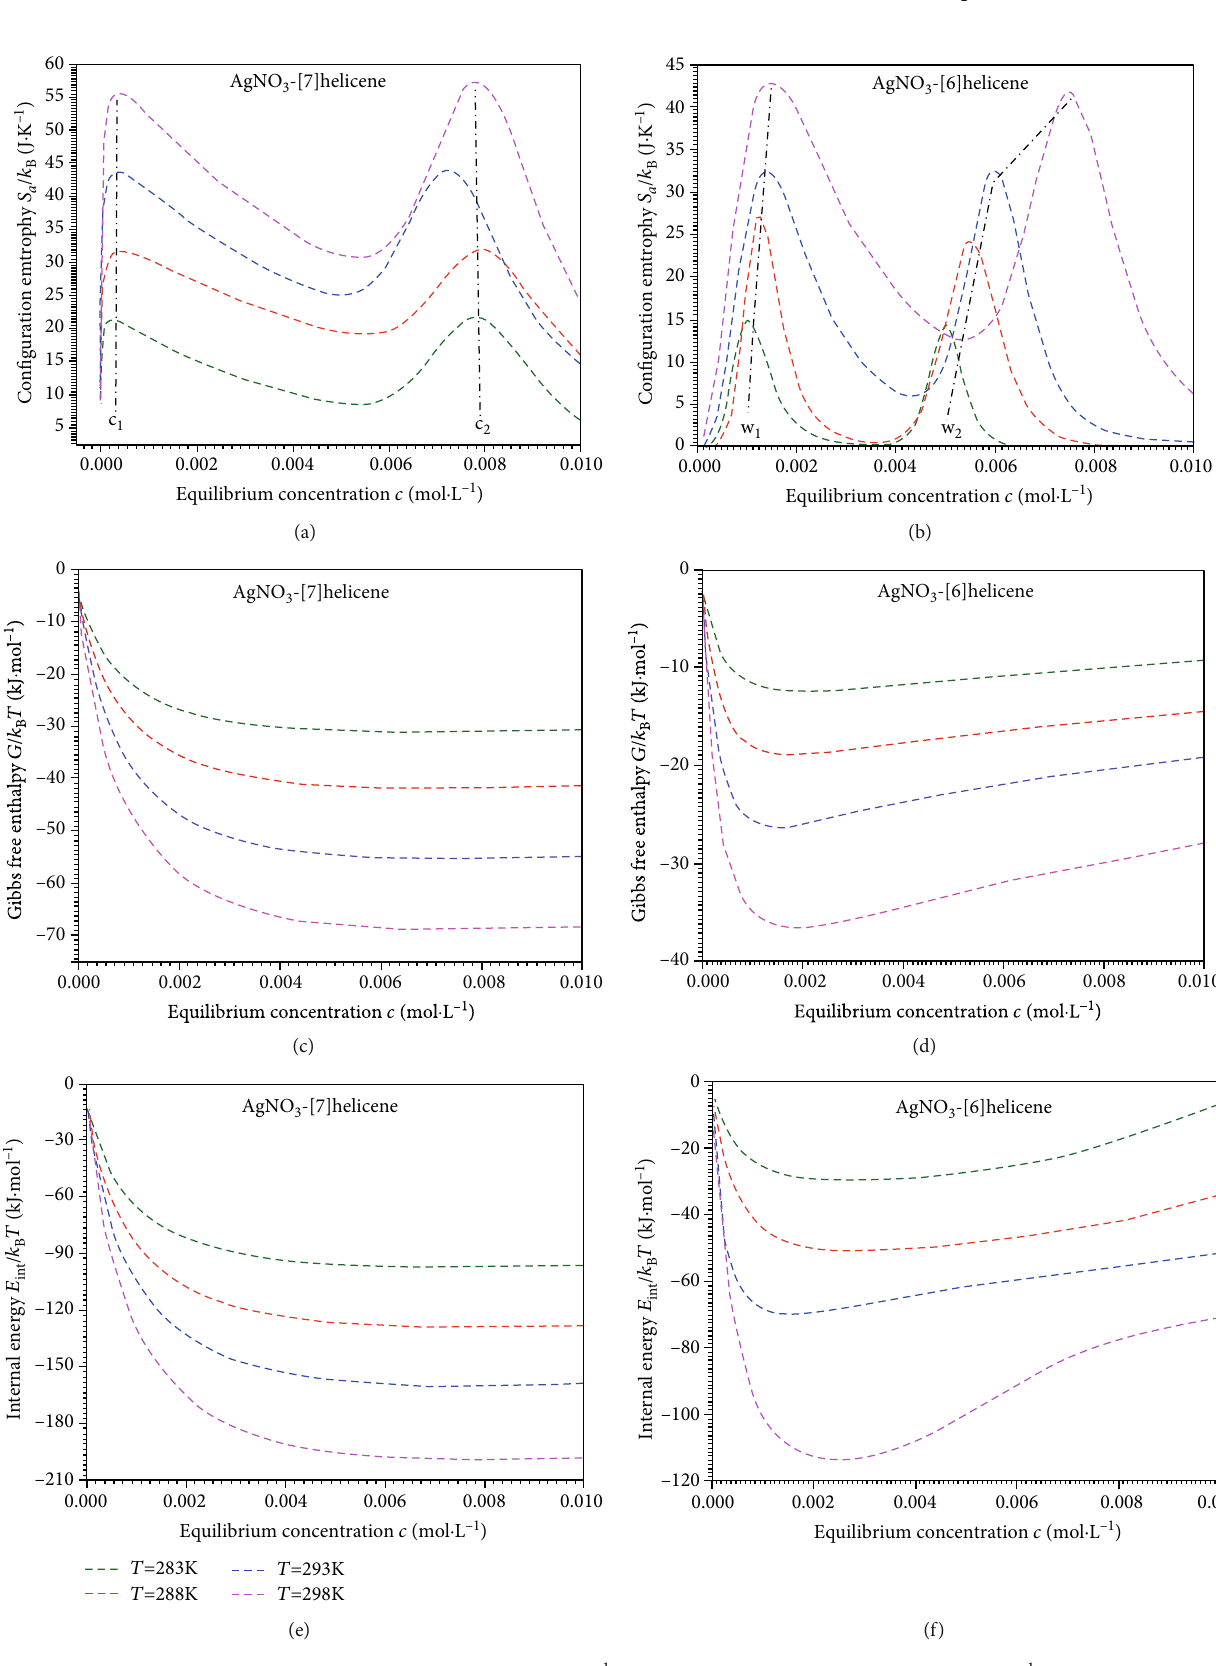
/ k (J · K -1 ), (c, d) the Gibbs free enthalpy G / k B a